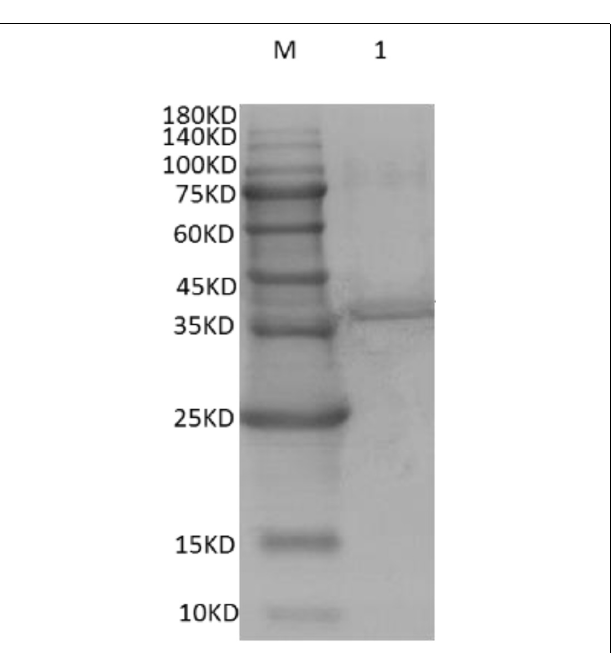
FIGURE 3 | Western blot of purified recombinant DpWRI1-like (1 µ g). The first antibody and the second antibody were anti-6 × His rabbit polyclonal antibody and HRP-conjugated goat anti-rabbit IgG,